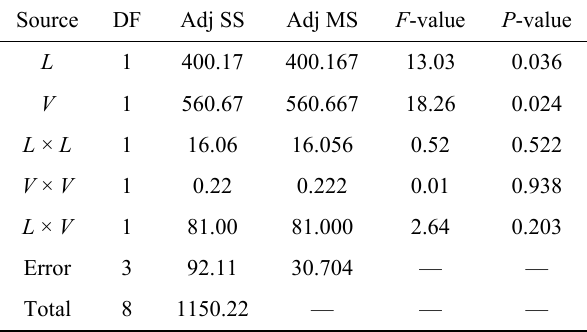
Table 10 Analysis of variance for S dq